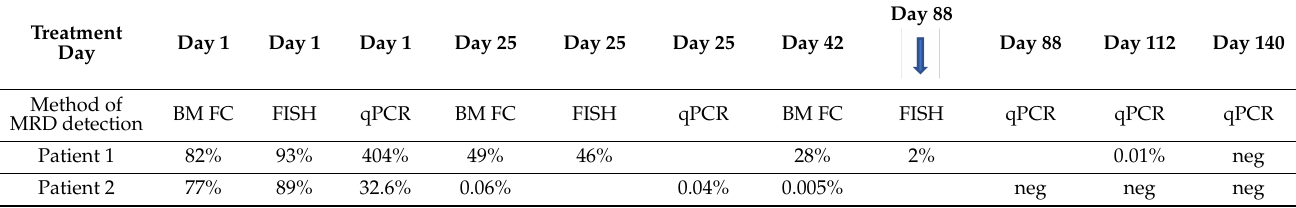
Table 4. MRD monitoring in two AML M3v cases. The level of PML-RARA and NPM1-RARA transcripts were normalized to the reference gene ABL1 as the normalized copy number (based on the ∆ C p